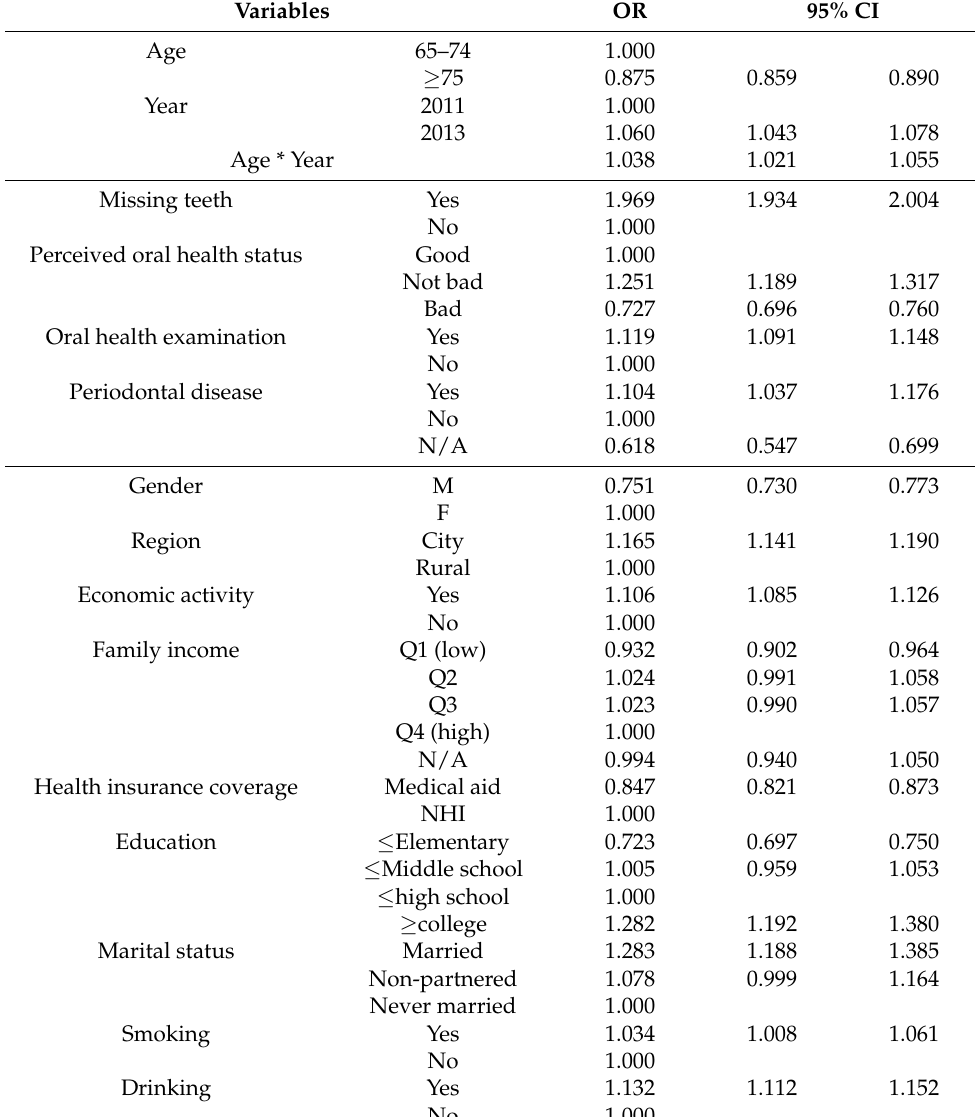
Table 2. Analysis of association between denture procedure and various